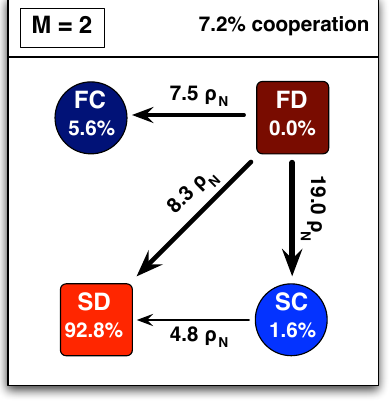
Figure 4. Transition probabilities and stationary distributions for a population with M = 2 different linking strategies. In the limit of rare mutations, the dynamics reduces to transitions between homogeneous states of the population [80,81]. The arrows indicate those transitions for which the fixation probability is greater than neutral fixation, ρ = 1 . The explicit values were obtained analytically with the pairwise comparison rule N N (see Equation 5). Adaptive network dynamics allows C’s , in the form of SC or FC , to remain in the population for 7 . 2% of the time. D’s dominate because of the flow from FD to SD , either directly or by using the alternative route via SC . ( N = 100, β = 0.01, T = 2.1, R = 2, S = 0.9, P = 1, c = 0.16, δ = 0.3). Figure reproduced from [62]. M =